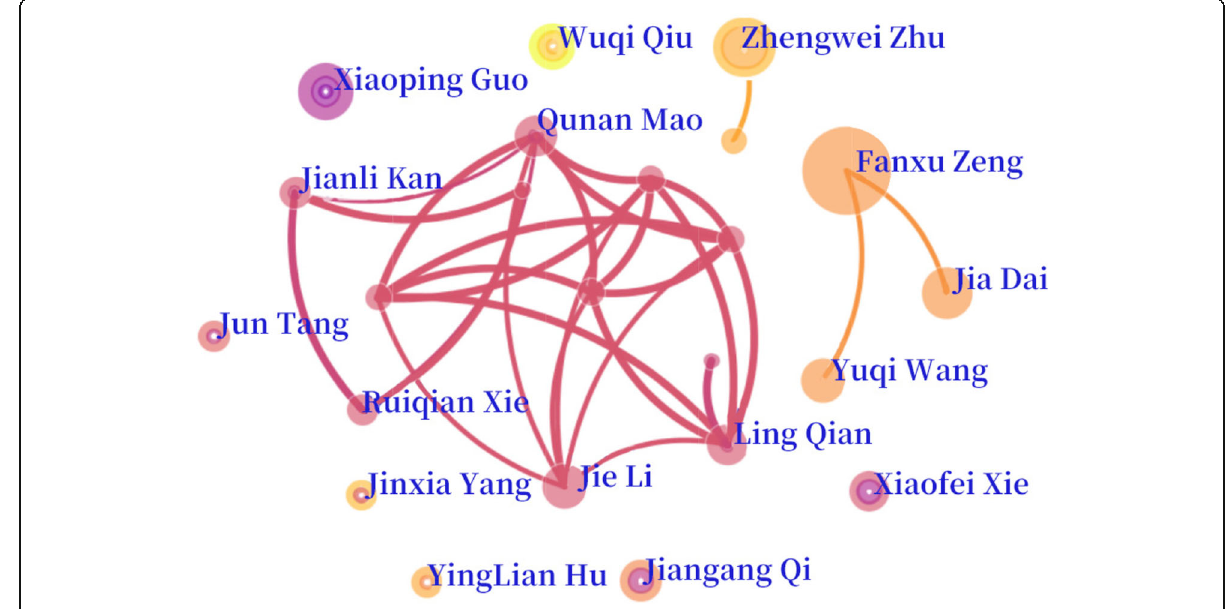
Fig. 3 Co-author network of Chinese database